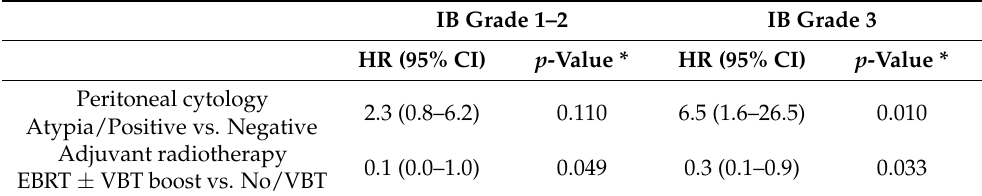
Table 4. Multivariate analysis of prognostic factors on recurrence-free survival in IB